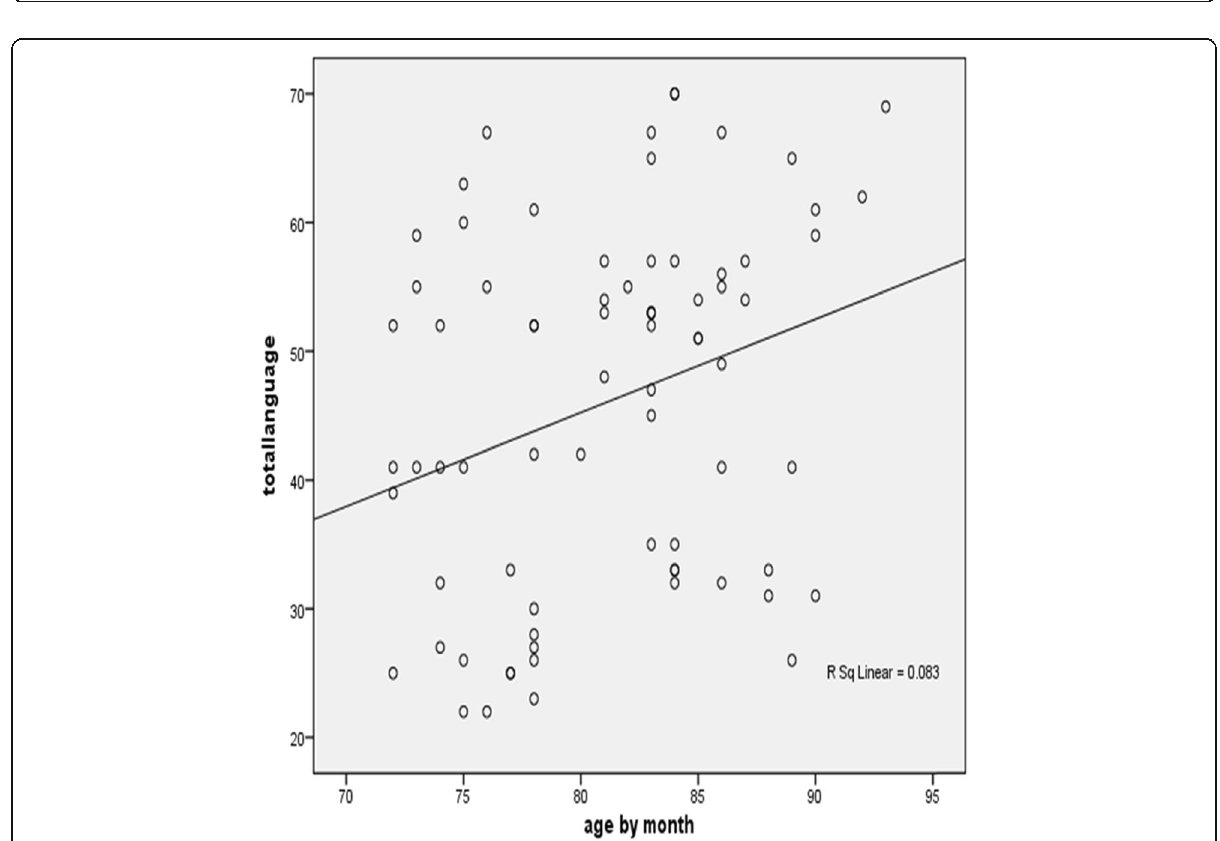
Fig. 3 Shows significant positive correlation between all children chronological ages (the three groups A, B, and C) and their total language ages ( R =